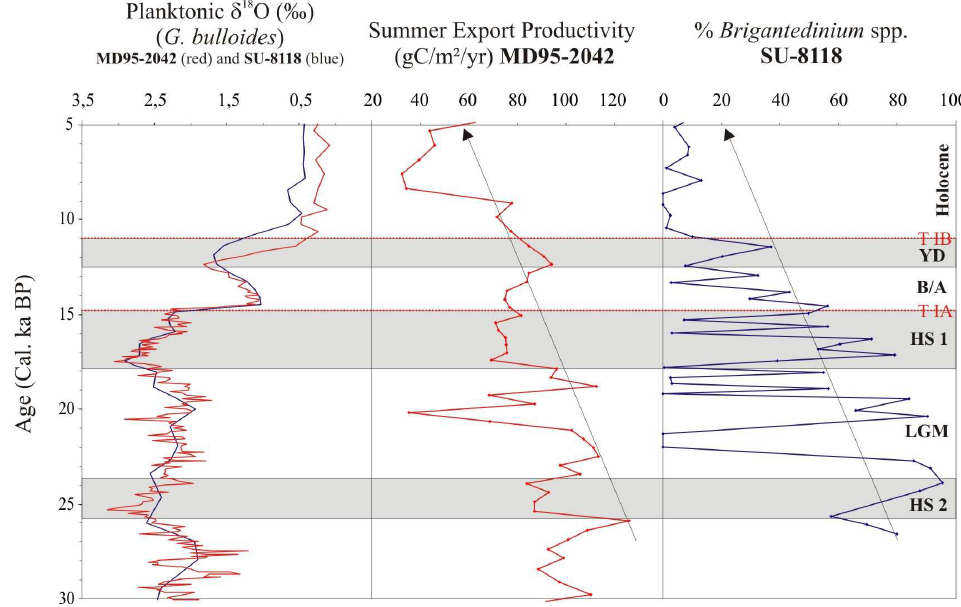
Fig. 10. Summer export productivity estimated for core MD95-2042 (Salgueiro et al., 2010) versus relative abundances of Brigantedinium spp. obtained in core SU-8118 (Turon et al., 2003). The planktonic δ 18 O records provide the stratigraphic framework for the two sedimentary